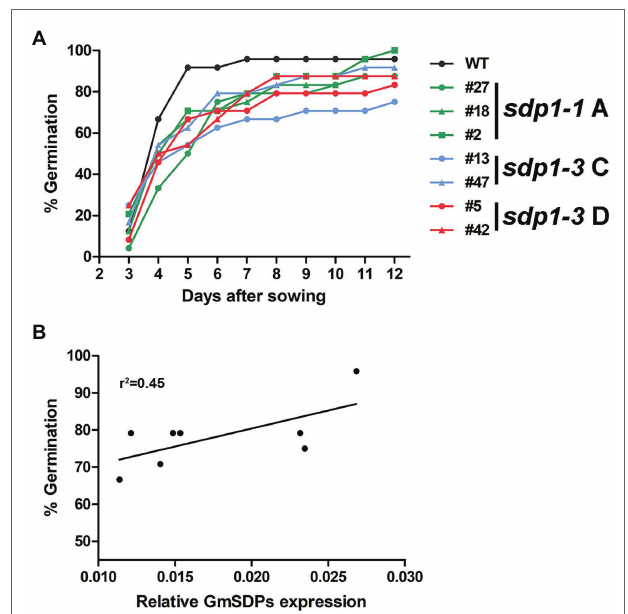
FIGURE 7 | Suppression of GmSDP1 delays germination. (A) Germination rates of seeds from wild-type (WT) and GmSDP1 -suppressed transgenic plants. Values shown represent the mean germination rate of seeds harvested from two plants for each genotype. (B) Correlation between germination rate and total GmSDP1 expression in R7